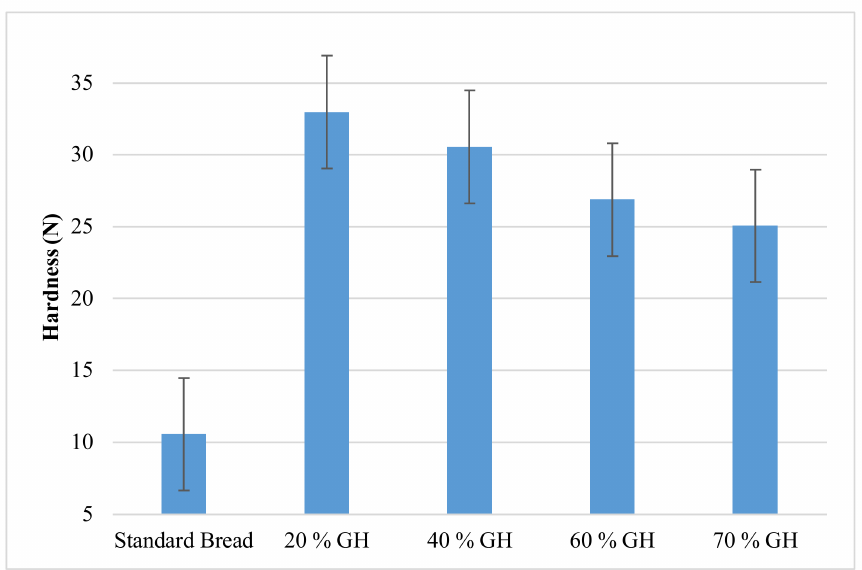
Figure 6. Hardness profile of standard and GH breads with promoters (20–70%).